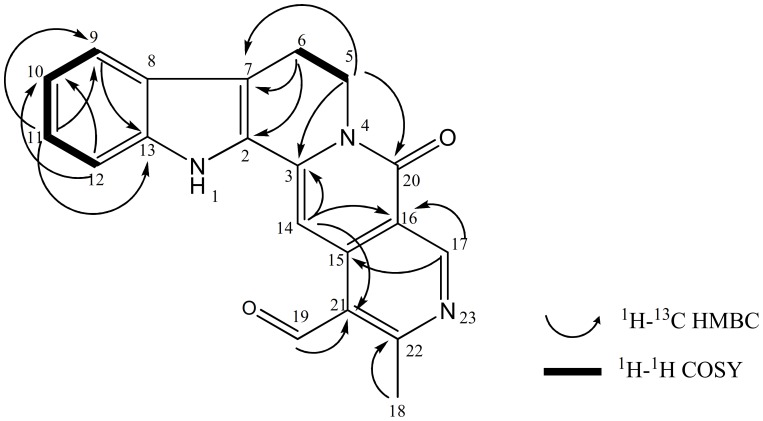

1H-1H COSY and HMBC correlations of subditine (1).